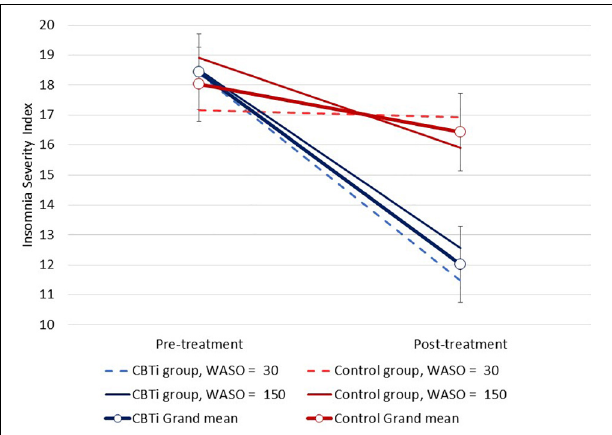
FIGURE 4 | Modeled data illustrating the effect of pre-treatment N3 sleep (min), group (CBTi, control), and time (pre-treatment, post-treatment) on the Insomnia Severity Index (CI). Pre-treatment N3 sleep was retained as a continuous predictor and data are plotted according to intercept, slopes and